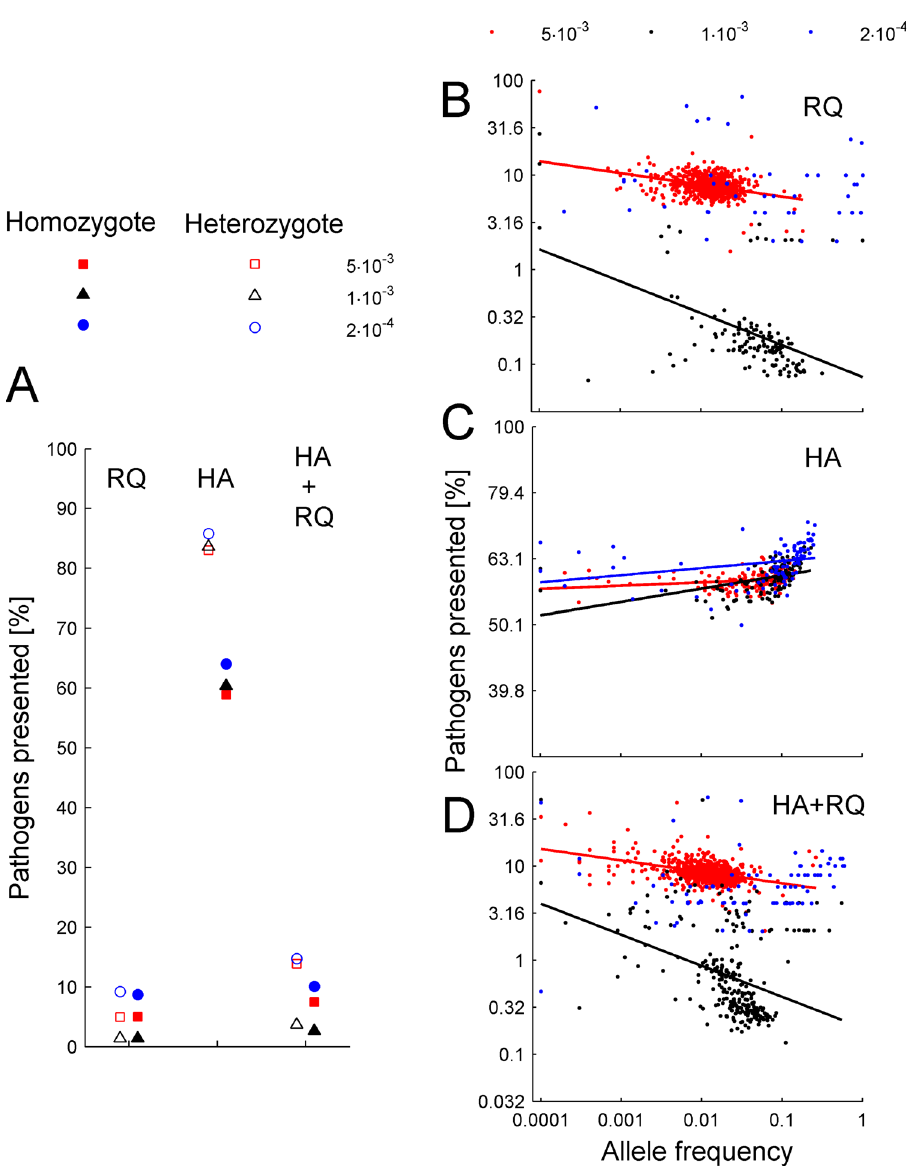
Fig 1. Patterns of frequency dependence and heterozygote advantage that emerged from the model. (A) Comparison of pathogen recognition abilities between heterozygotes and homozygotes, depicted as averages across the last 6000 generations from 10 independent runs. Mutation rates for (A-D) are given in the legends; host population size N = 5000 individuals. (B-D) Relationship between the expected proportion of pathogens recognized by MHC molecules (taken at generation 2000, i.e. at the time when allele numbers stabilized) and allele frequency is shown for three scenarios: Red Queen process (RQ), heterozygote advantage (HA), and both (HA+RQ). Points represent MHC alleles; colors denote pathogen mutation rates (see the legend). Lines represent the statistically significant trends in frequency dependence (see Table A in S2